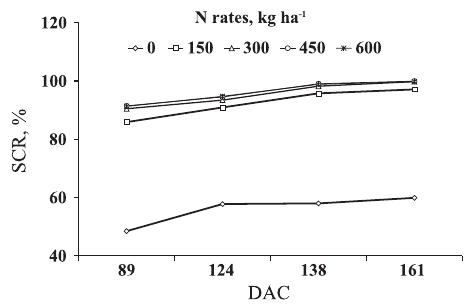
grass.Figure 2. Bermuda grass soil cover rate during the crop cycle in relation to N